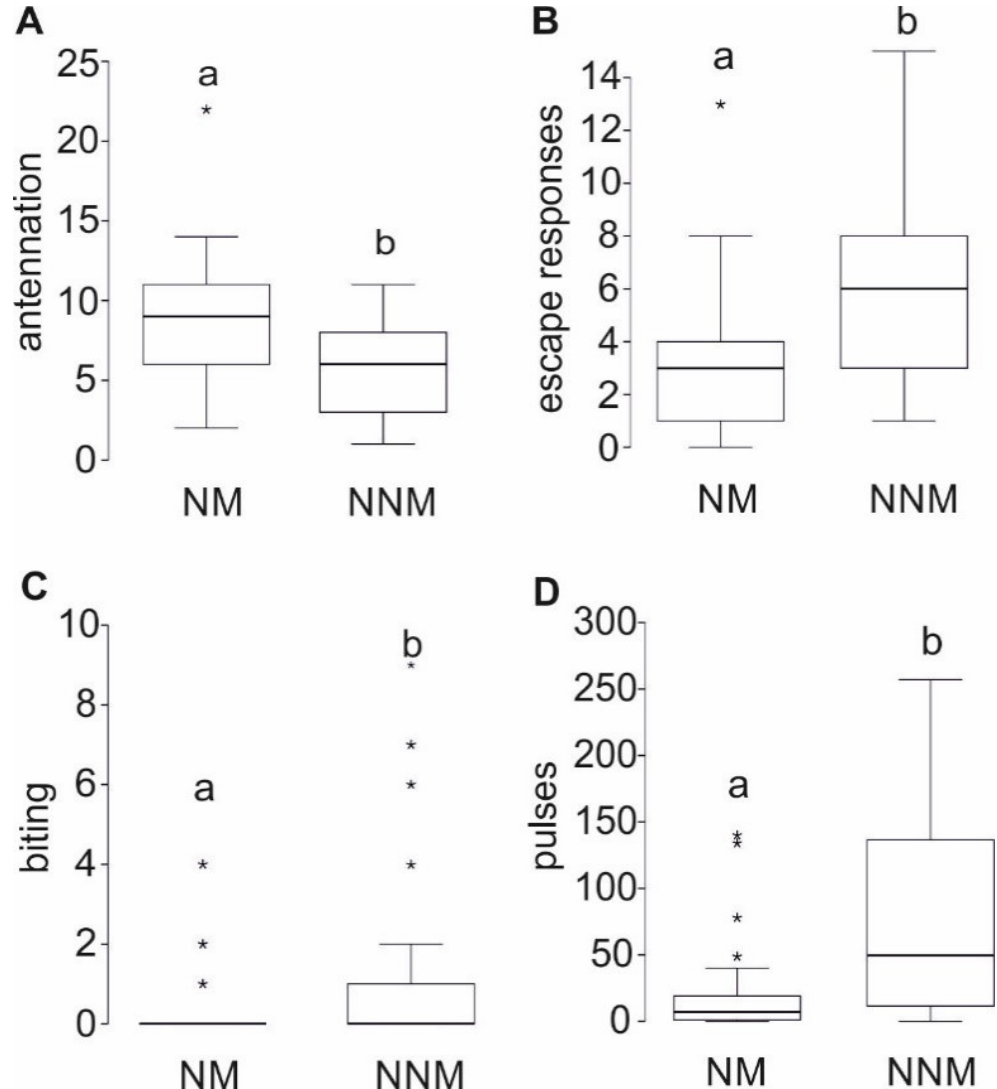
Figure 3. Interaction between nestmates (NM) and non-nestmates (NNM) of A. ferruginea during 5-min arena experiments. ( A ) Nestmates have significantly more antennal contacts than non-nestmates (F = 33.436; p < 0.001). ( B ) Non-nestmates showed significantly more escape responses than nestmates (F = 6.576; p = 0.013) ( C ) Non-nestmate performed significantly more biting attacks than nestmates (F = 5.743; p = 0.02) ( D ) Non-nestmates produce significantly more vibrational pulses than nestmates (F = 6.597; p = 0.013)Boxplots show median (thick horizontal line), upper and lower quartile (box), 1.5 × inter quartile range (whiskers) and outliers (asterisks). Different letters indicate significant differences. Sample size: nestmates = 26, non-nestmates = 28.